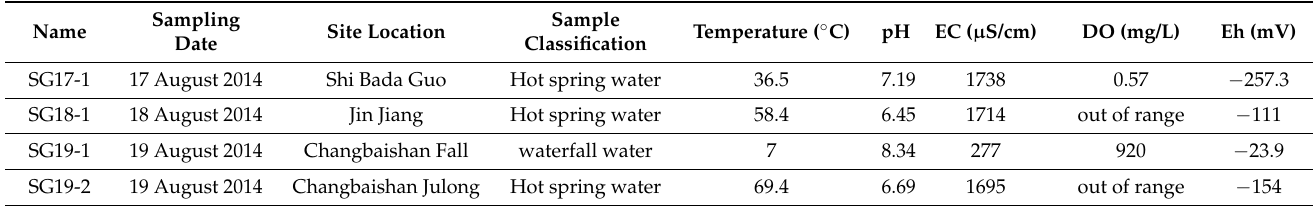
Figure 1. Location map showing the bottled water sample (BSS and BDS) and hot spring waters locations adjacent to Mt. Baekdu (Changbai). Baeksansu, BSS; Baekdusansu, BDS. Table 1. Basic physical and chemical properties of hot spring water and stream water near to Mt. Baekdu area. EC, Electrical Conductivity; DO, Dissolved Oxygen; Eh,